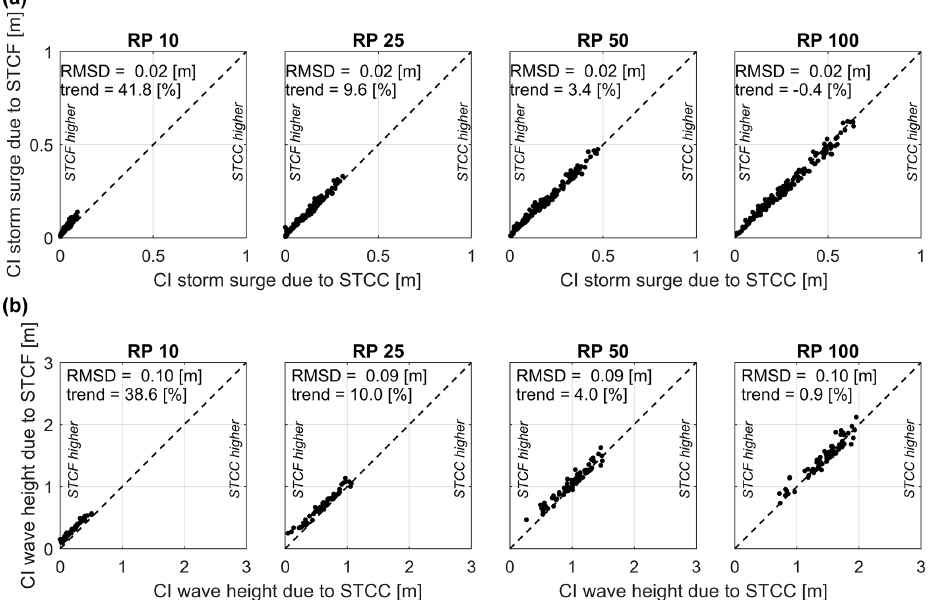
Figure B7. Scatterplots of 95% confidence intervals (97.5th minus 2.5th percentile) for storm surge (a) and wave heights (b) , both resulting from STCC ( x axis) and STCF ( y axis), for return periods of 10, 25, 50 and 100 years, for all locations along the Bay of Bengal. Root-mean- square differences (RMSDs) and the trend (%) of STCF compared to STCC are also shown.